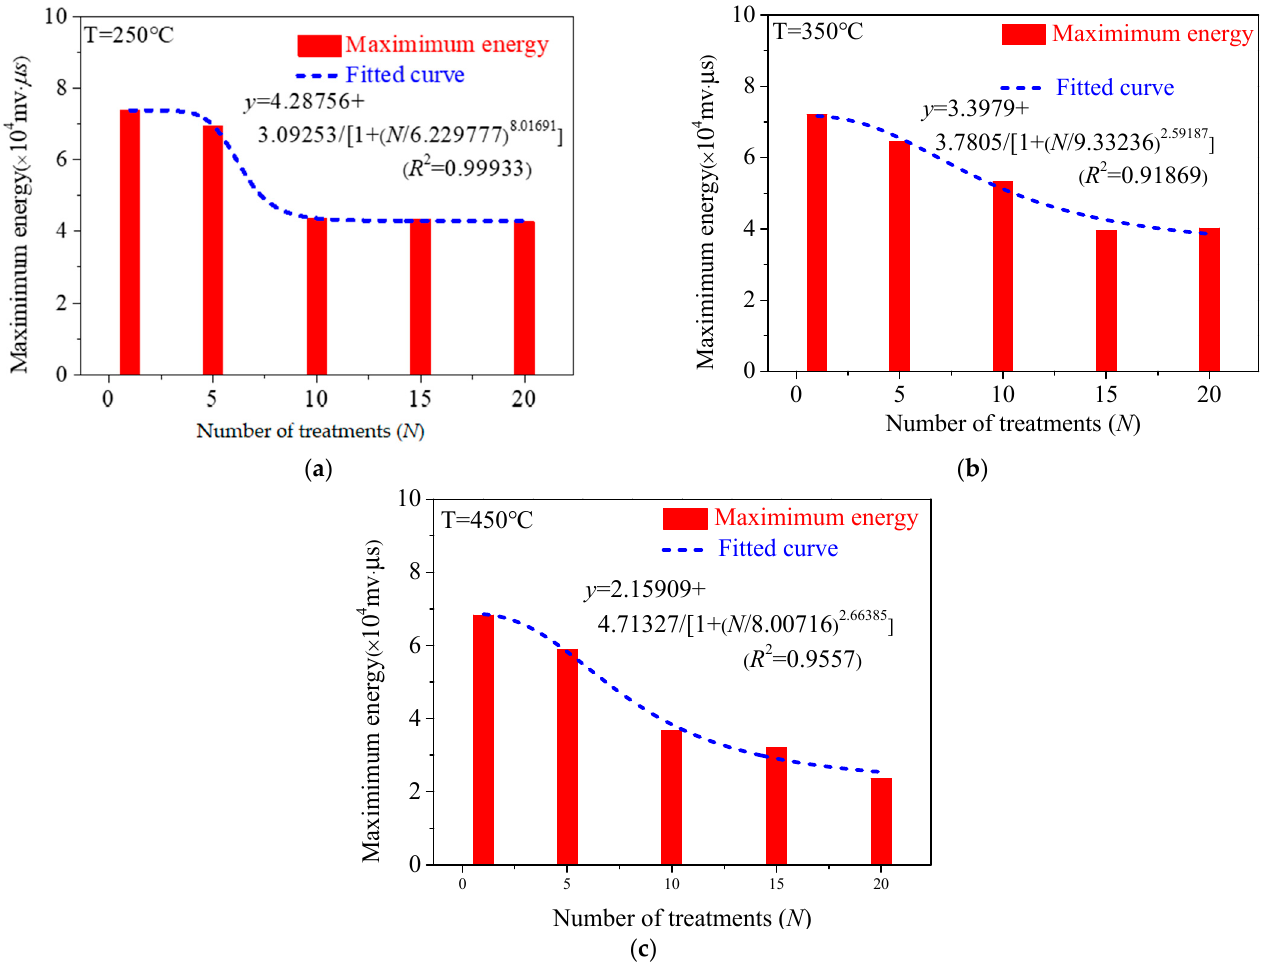
Figure 9. Trends in the maximum energy value of acoustic emission of specimens during uniaxial compression. ( a ) T = 250 °C. ( b ) T = 350 °C. ( c ) T = 450 °C.